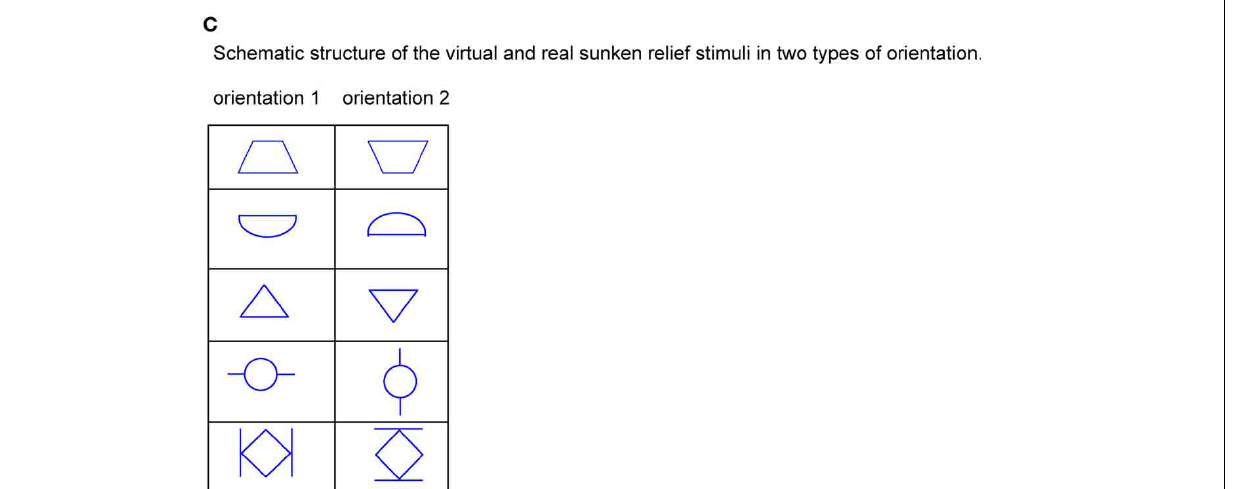
Frontiers in Psychology |